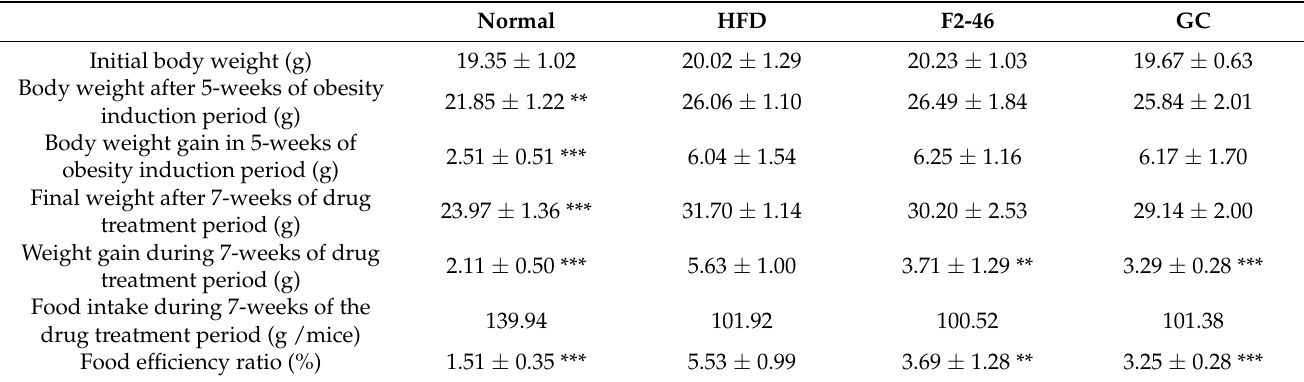
Table 4. Diet-induced obesity and controlling of weight gain by F2 in obese mice.